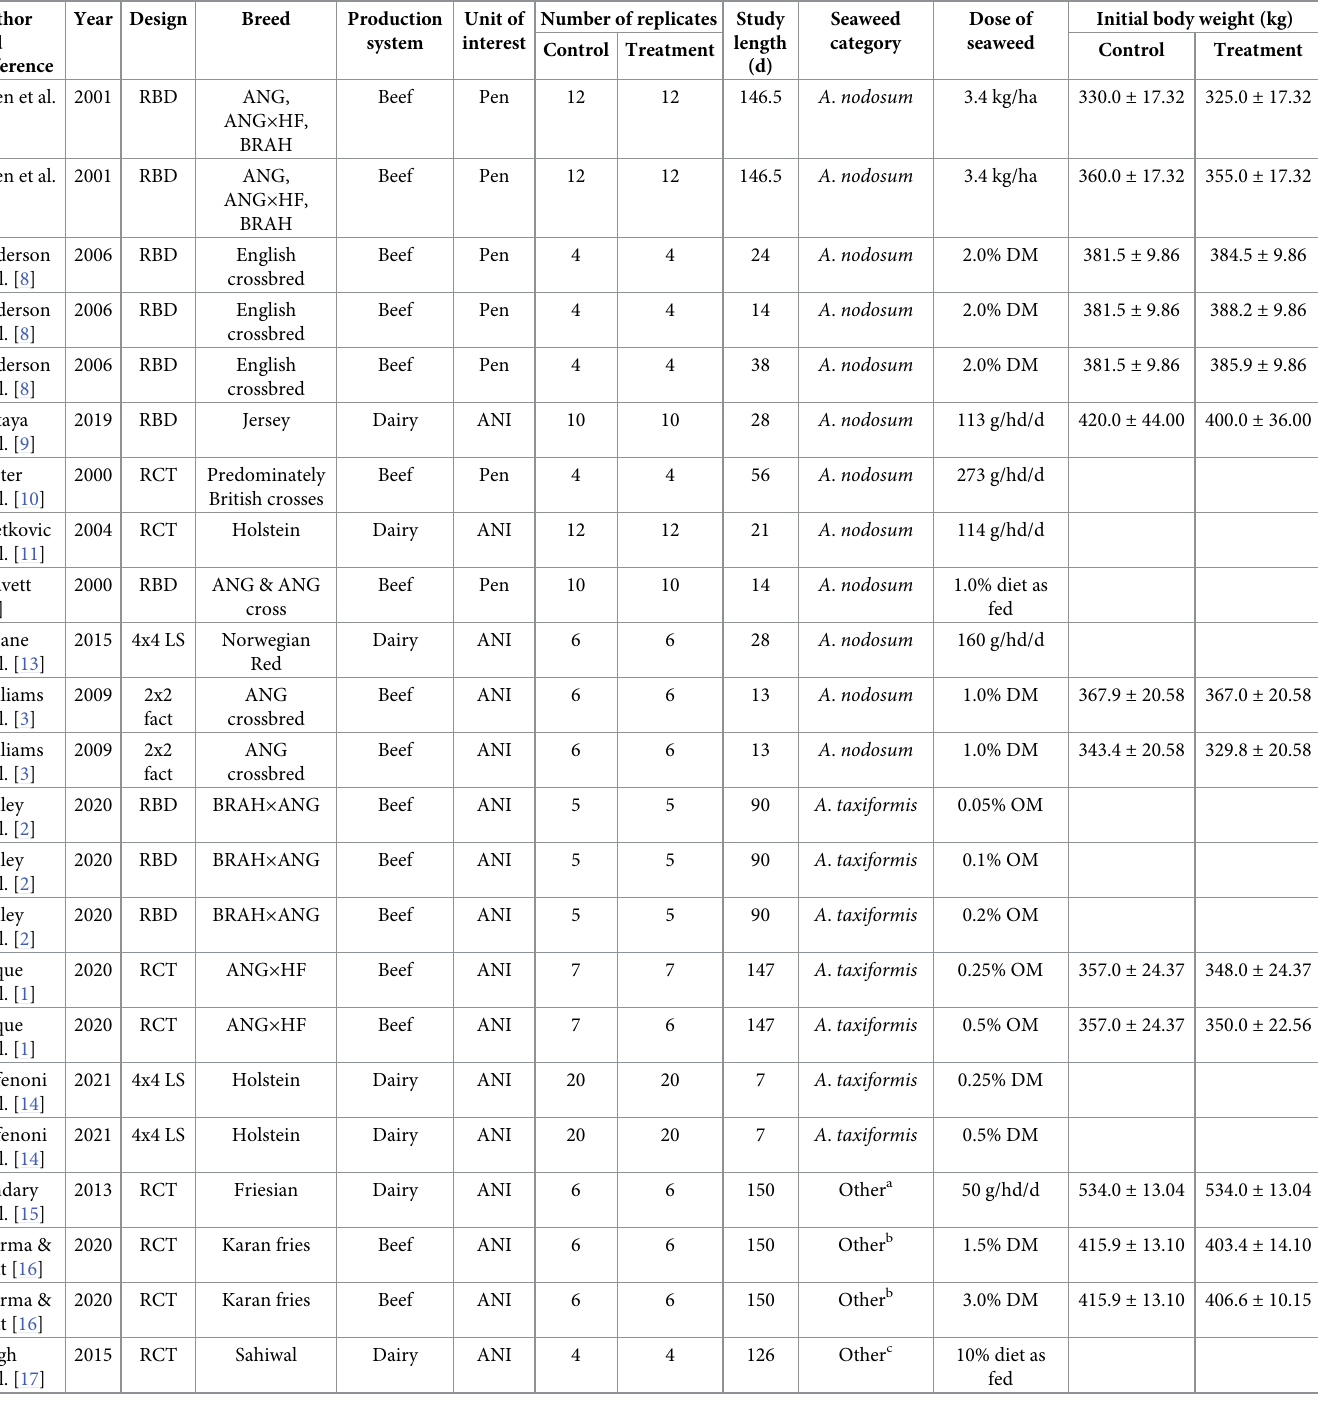
Table 1. Descriptive information for the comparisons included in the